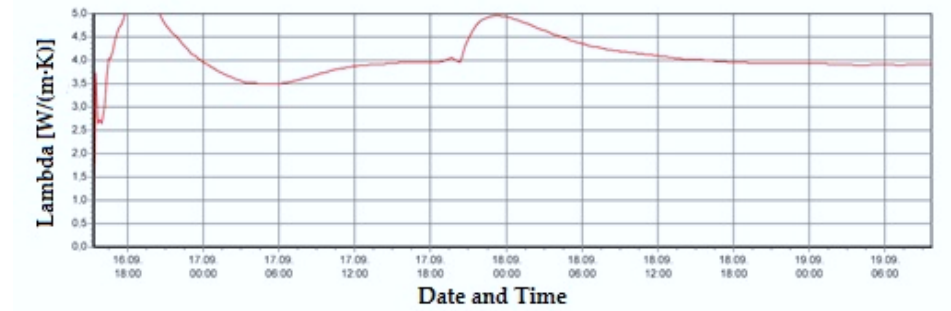
Figure 4. Temperatures achieved during the thermal response test [9,16].